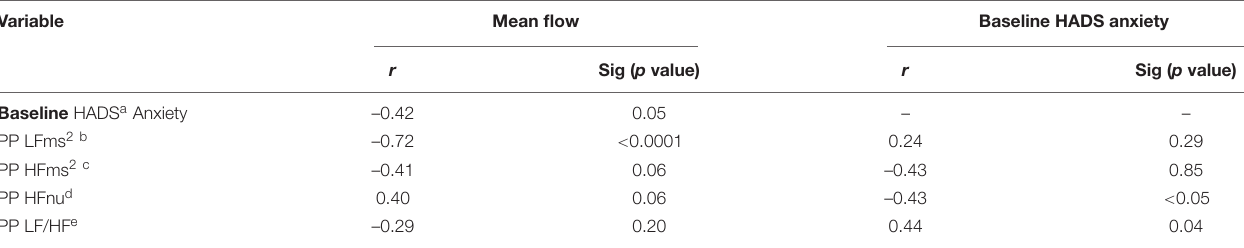
Baseline HADS a